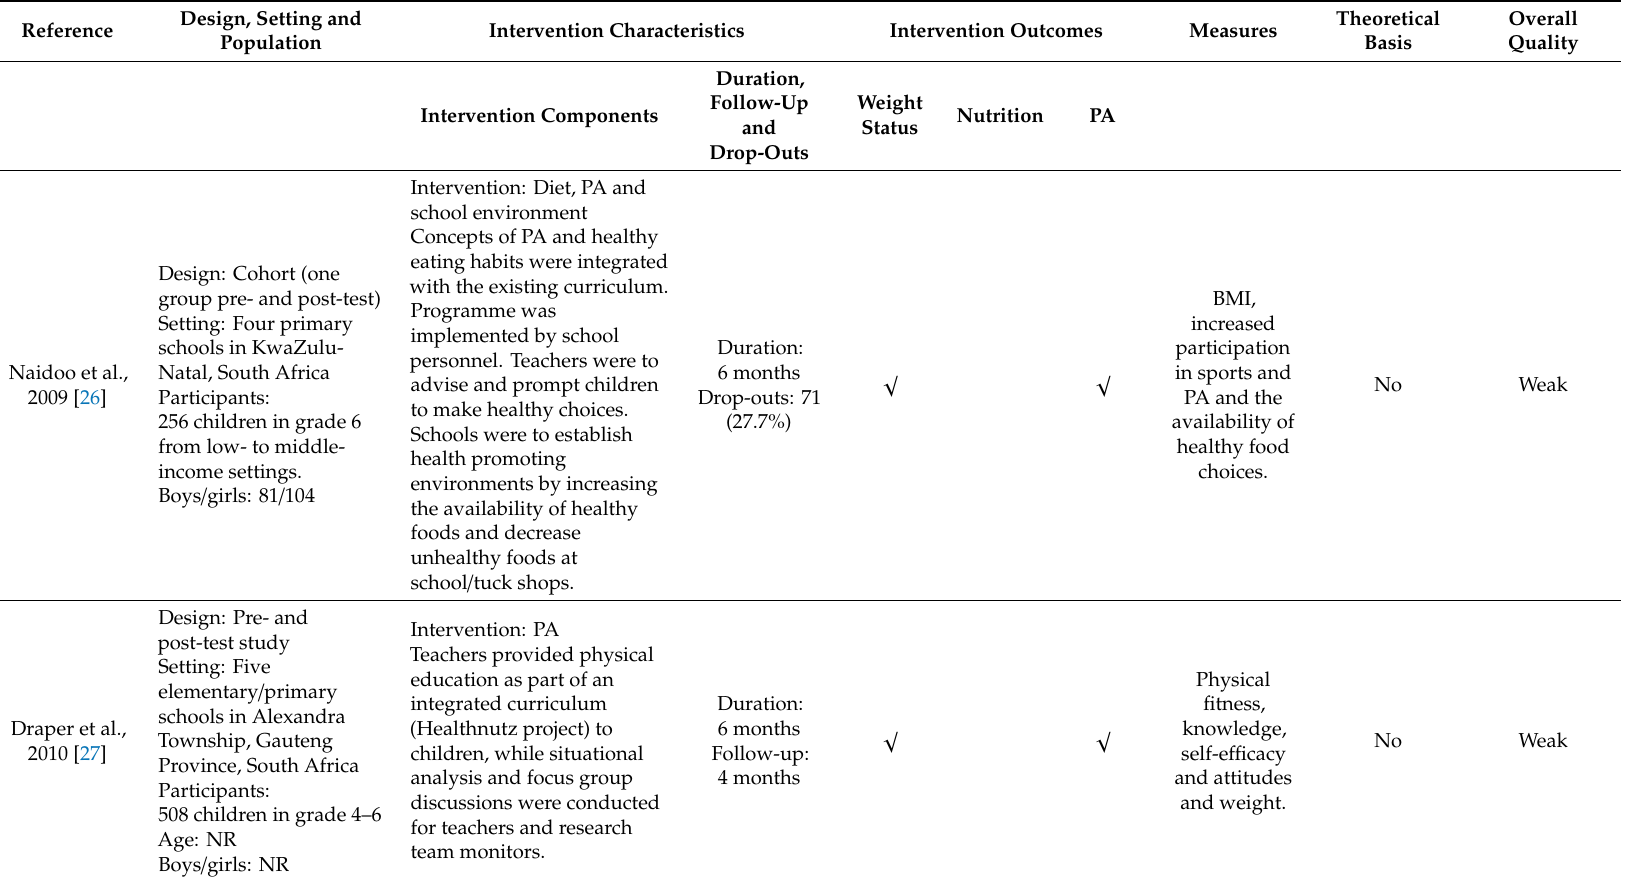
Table 1. Summary characteristics of the included studies on school-based interventions targeting nutrition, physical activity, and weight status of children in African